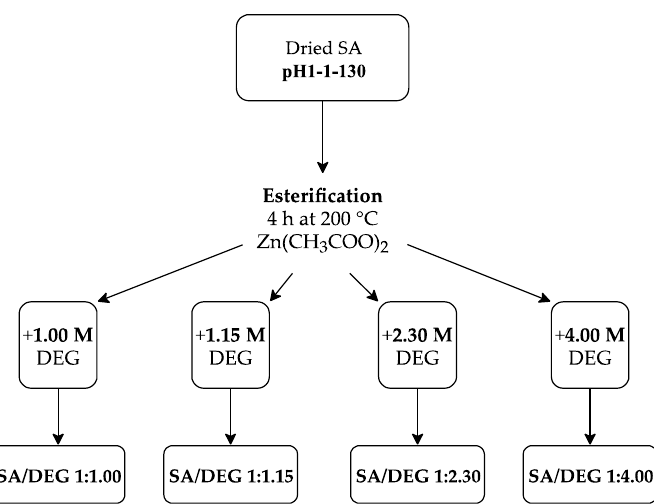
Figure 4. Experimental scheme for obtaining polyols from the SA sample.